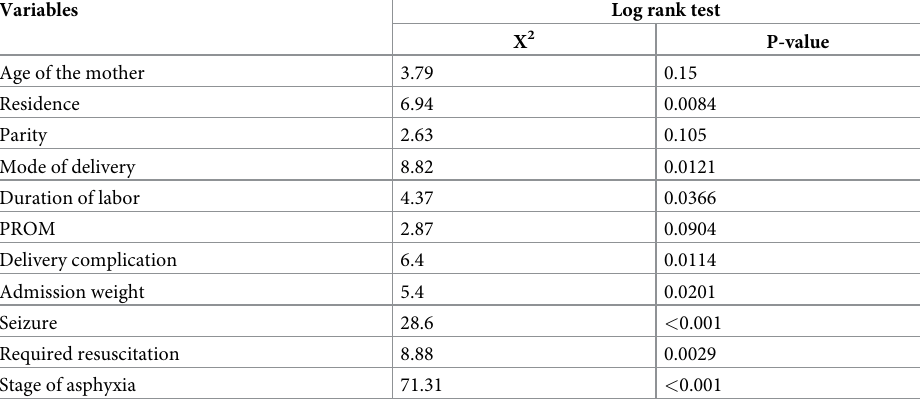
Table 4. Log-rank estimate of variables on mortality of asphyxiated neonates admitted to the NICU of DCSH, Amhara region, Northeast Ethiopia (N = 378). Variables Log rank test X 2